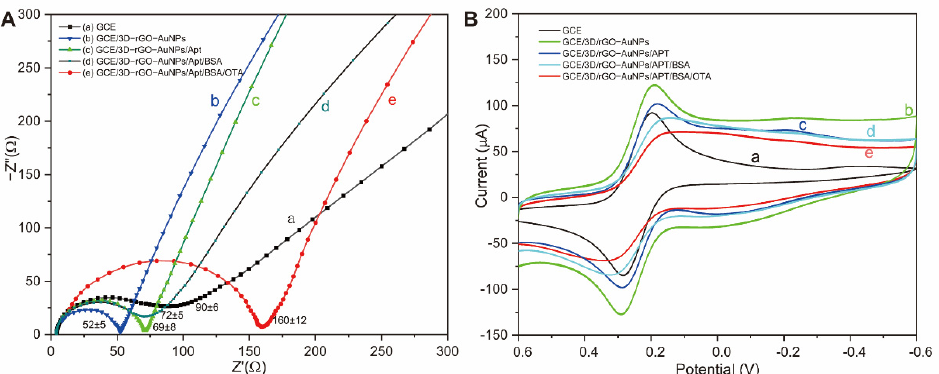
Figure 5. ( A ) Nyquist plots and ( B ) CV curves of ( a ) the bare GCE, ( b ) GCE/3D-rGO-AuNPs, ( c ) GCE/3D-rGO-AuNPs/aptamer, ( d ) GCE/3D-rGO-AuNPs/aptamer/BSA, and ( e ) GCE/3D-rGO- AuNPs/aptamer/BSA/OTA in a solution of phosphate buffered saline (PBS) pH 7.4 containing 1 mmol L − 1 [Fe (CN) 6 ] 3 − /4 − and 0.1 mol L − 1 KCl.